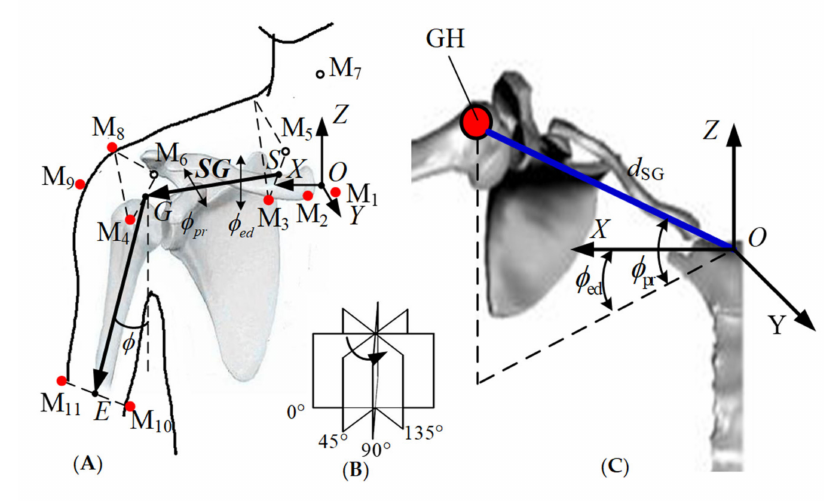
Figure 9. Klopˇcar Kinematic Model. ( A ) Reference points on the shoulder complex and the center of the GH joint in global coordinate frame. ( B ) four anatomical planes. ( C ) calculated position of the GH joint center relative to the global coordinate